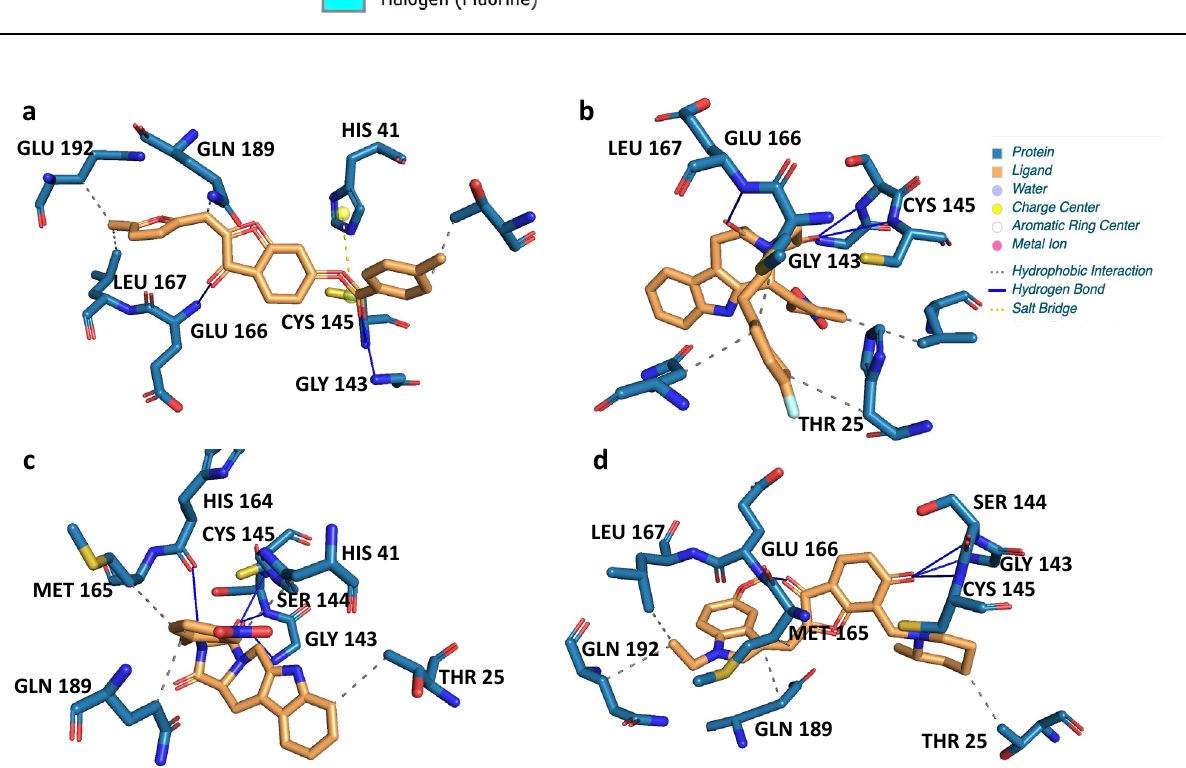
Figure 6. Schematics of the 3D interactions between the in vitro validated ligands and 6LU7 M pro structure. ( a ) CNP0061237; ( b ) CNP0381522; ( c ) CNP0375828; ( d ) CNP0366487.